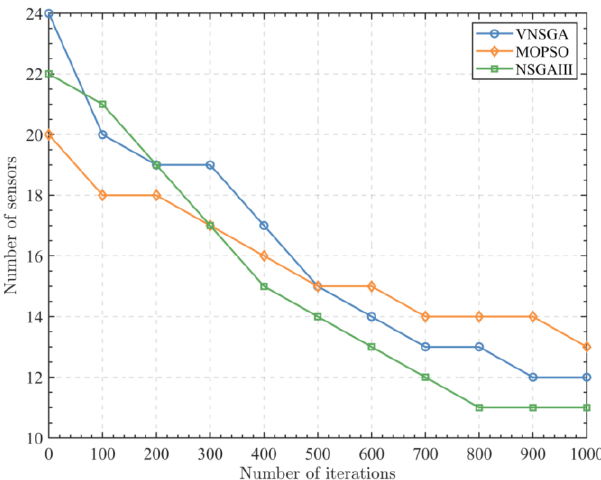
Figure 20. Number of sensors for three algorithms from different iterations for 75 m R s max and 150 m R c max with respect to area A.